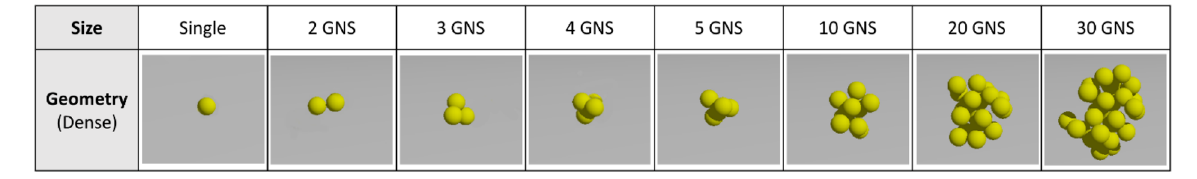
Table 3. Dense GNS aggregation